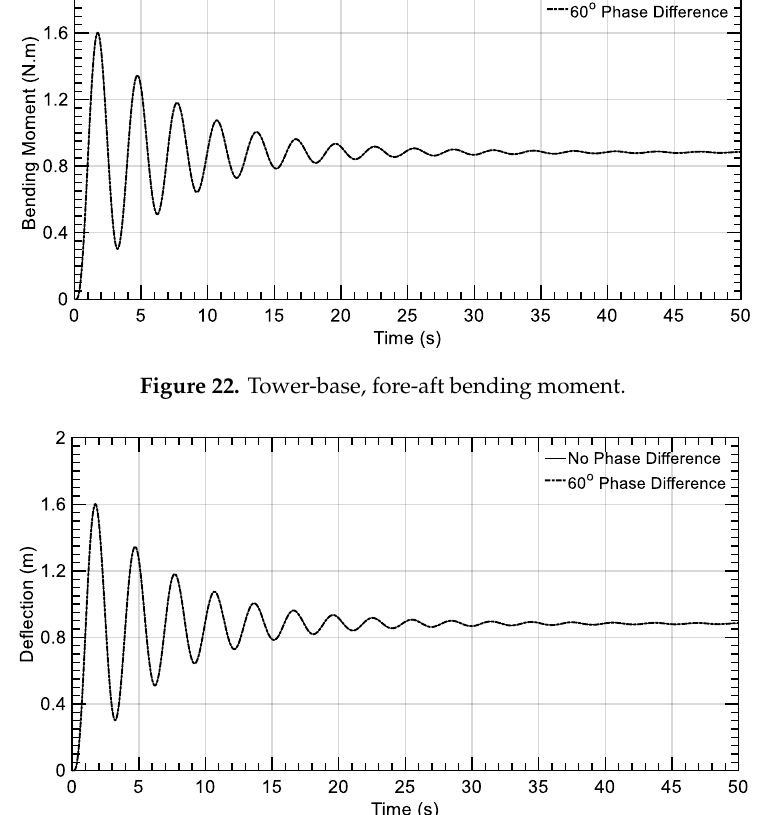
Figure 23. Tower-top, fore-aft deflection.